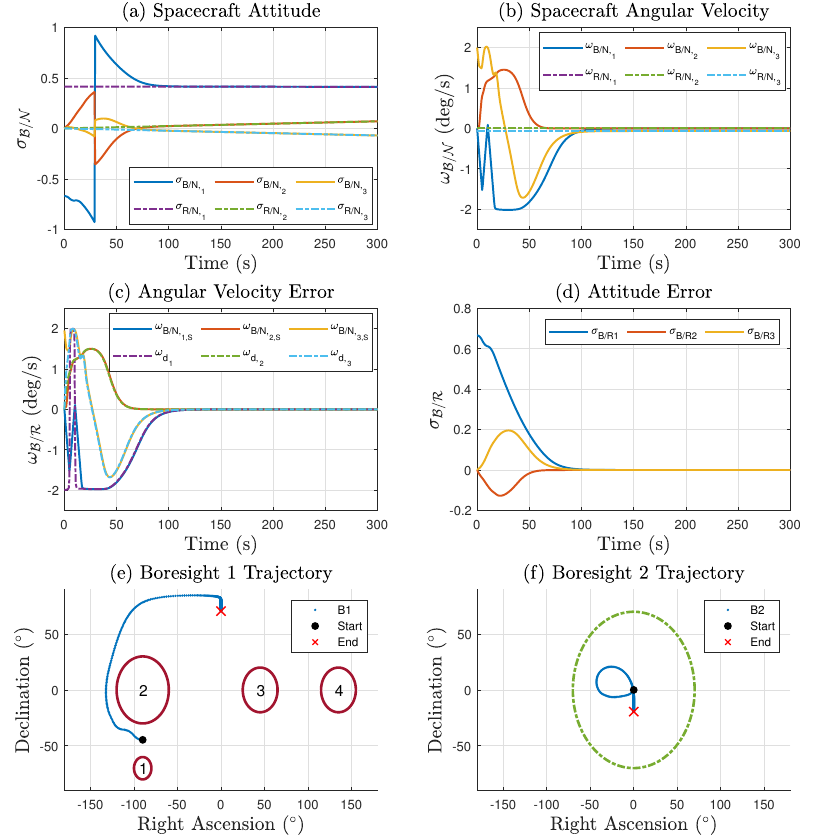
Figure 9. Unbounded Tracking Results in the Common Frame: ( a ) is the Spacecraft Attitude, ( b ) is the Angular velocity of the spacecraft, ( c ) is the Angular Velocity Error in the Common frame, ( d ) is the Attitude Error. ( e , f ) is are the boresight trajectories with respect to the constraints. The constraints represented by Equations (33) and (34), representing how close